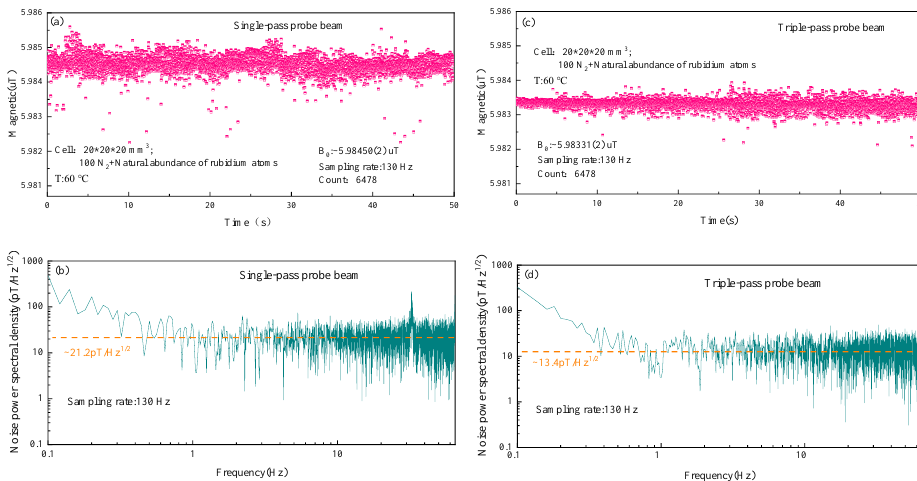
Figure 8. ( a ) Measured data set of the magnetic field for the single-pass probe beam case for a period of ∼ 7.7 ms; ( b ) Calculated PSD of data in ( a )—the dotted orange line indicates the calculated noise floor ∼ 21.2 pT/Hz 1/2 with a bandwidth of 65 Hz; ( c ) Measured data set of the magnetic field for the triple-pass probe beam case for a period of ∼ 7.7 ms; ( d ) Calculated PSD of data in ( c )—the dotted orange line indicates the calculated noise floor ∼ 13.4 pT/Hz 1/2 with a bandwidth of 65 Hz.